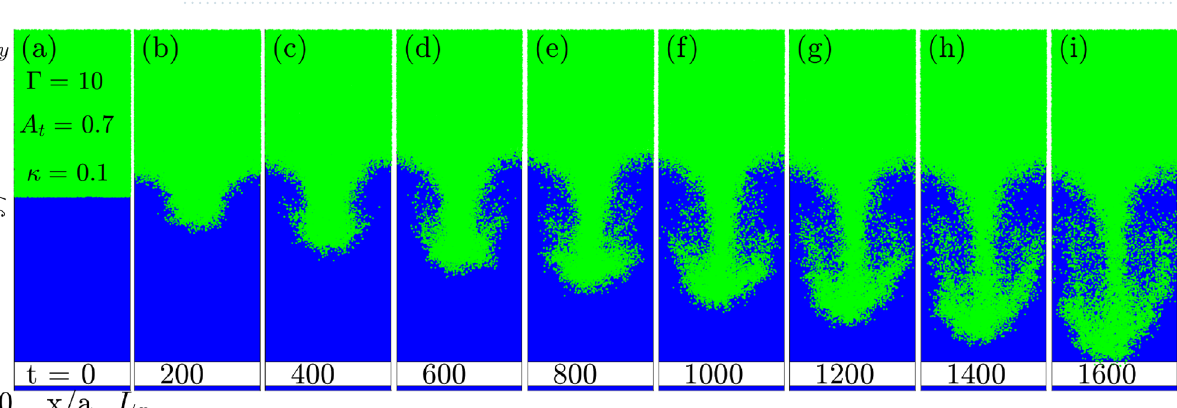
Figure 1. Time evolution of the RTI in a naturally evolved square system ( L x = L y ) through maximally growing modes. ( a ) The step density profile of the system, at time t = 0 ω − gravity. ( b – e ) reflect growing modes at interface at times t = 500 , 1000, 4000 and t = 5000 ω − Inset in subplots ( b , c ) are magnified views showing early growth of modes in thermal fluctuations at the interface.